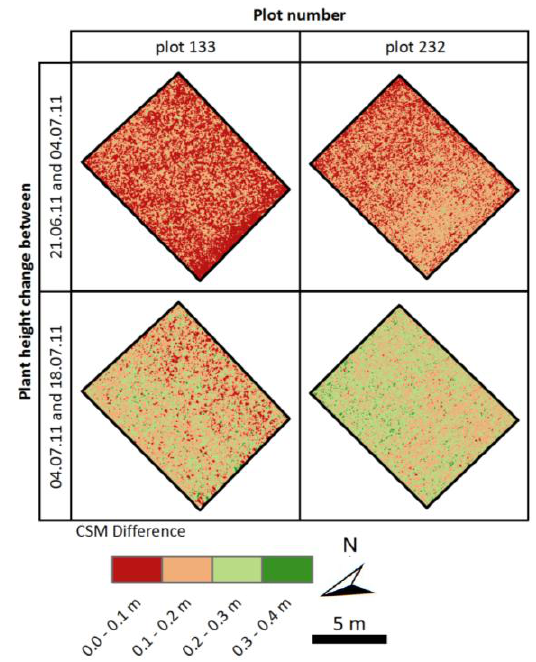
Figure 4. Maps of height difference between two consecutive CSMs.